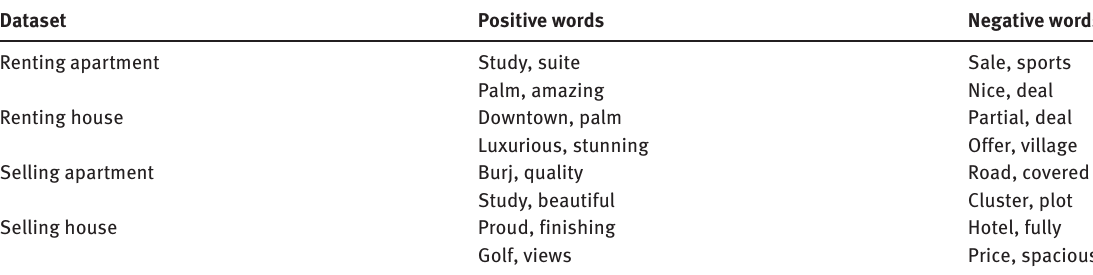
Table 9: Sample of Words (Uni-gram and Bi-gram) that Affect the Price of a Real-Estate Classified (Either Positively or Negatively).